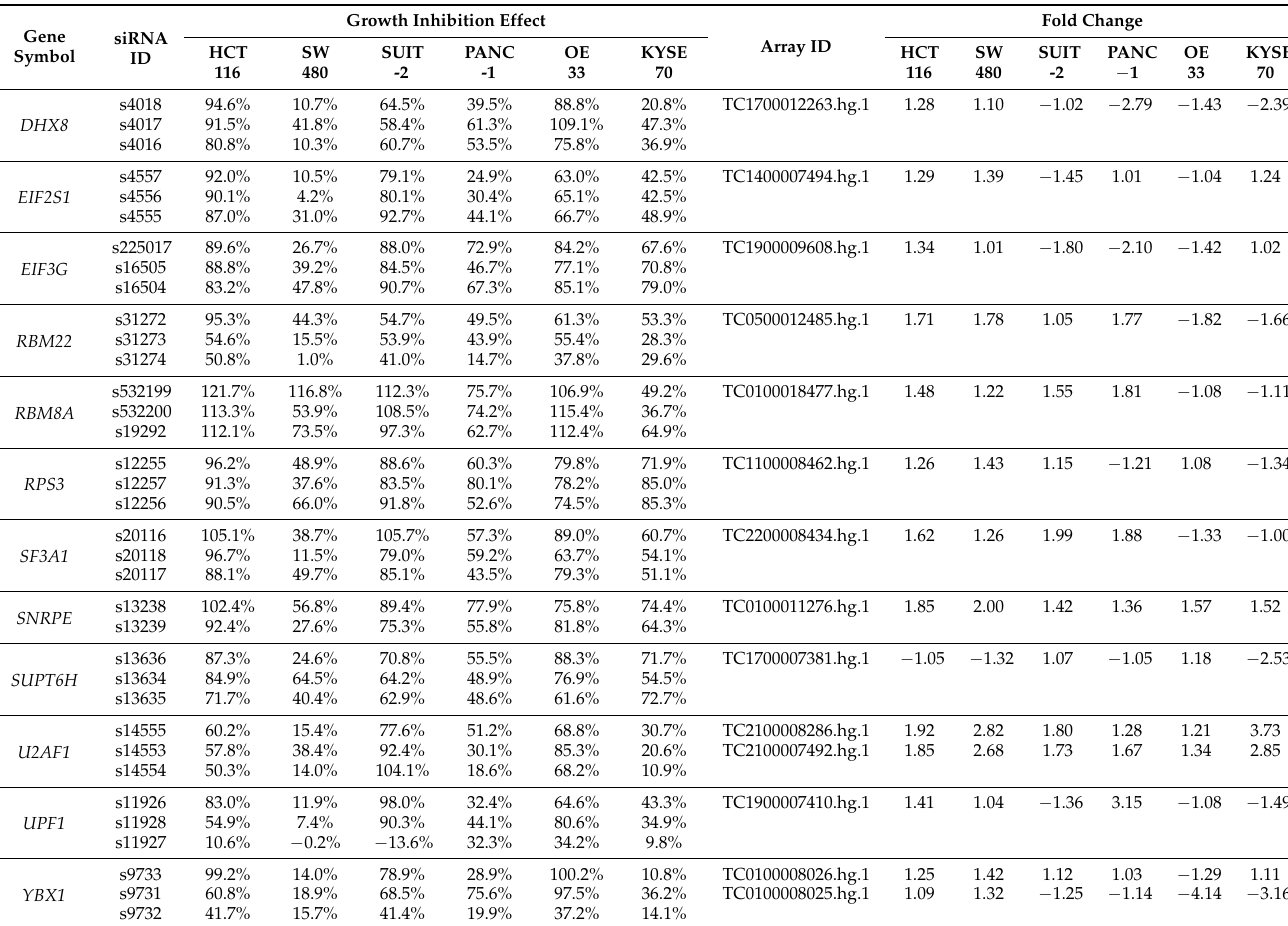
Table 2. The growth suppression effect and expressional changes.